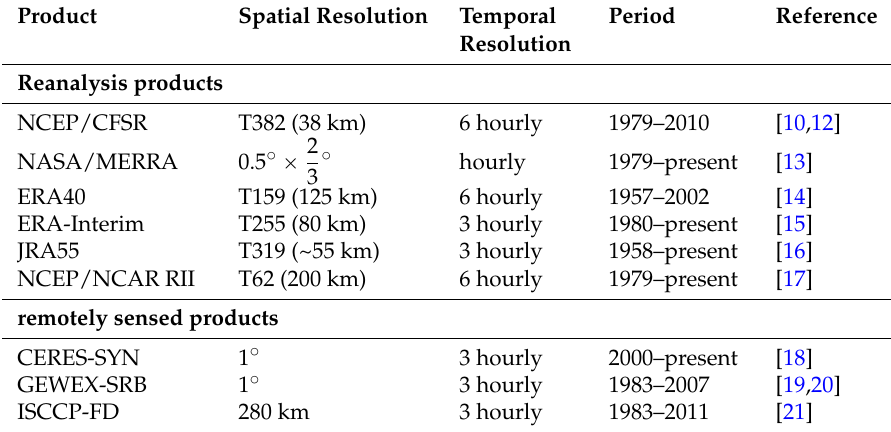
Table 1. Characteristics of the commonly used R n